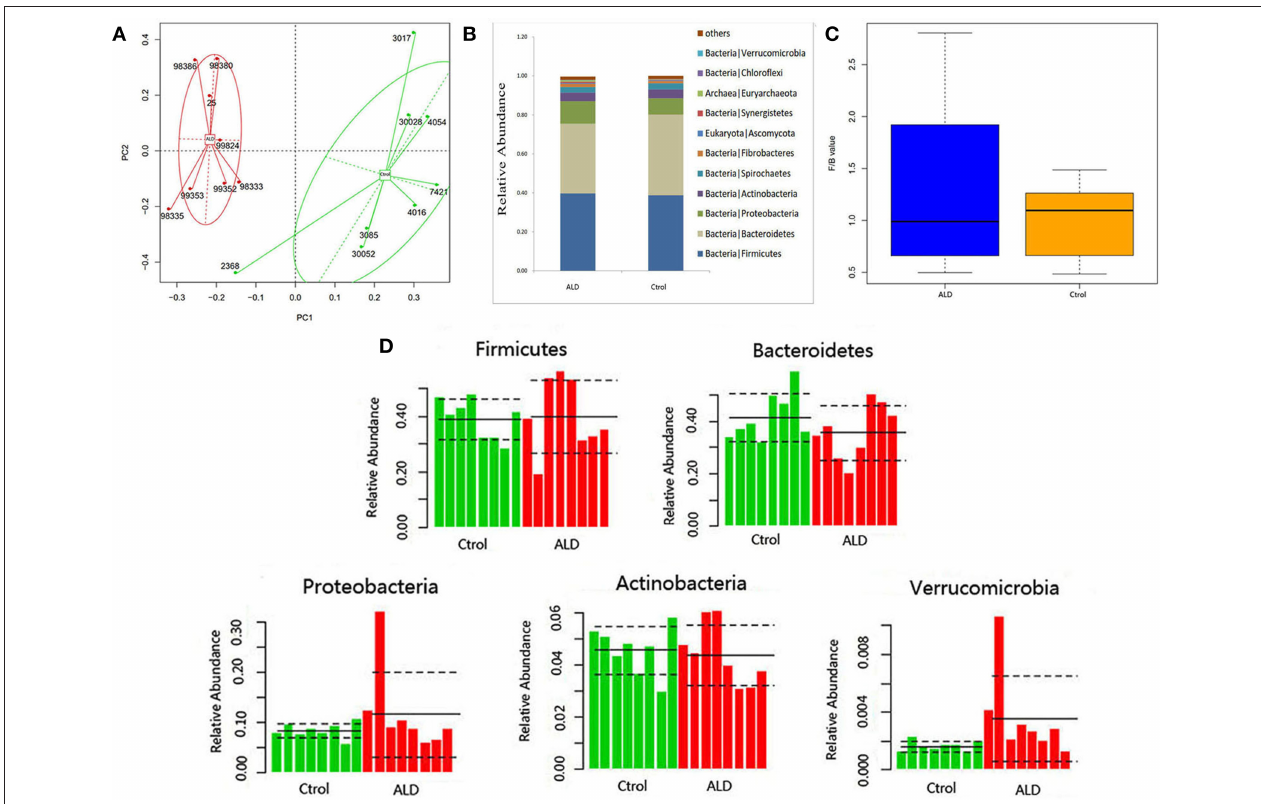
FIGURE 3 | (A) A PCoA analysis between ALD group and control group. (B) Relative abundance at the phyla. (C) The value of Firmicutes vs. Bacteroidetes of control and ALD monkeys. (D) The relative abundance of five main phyla of control and ALD